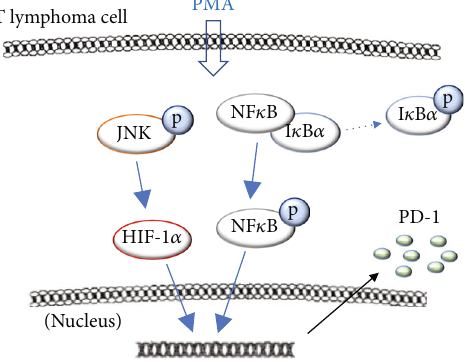
Figure 9: Proposed signaling mechanism for PMA-stimulated PD- 1 expression on EL4 lymphomas.